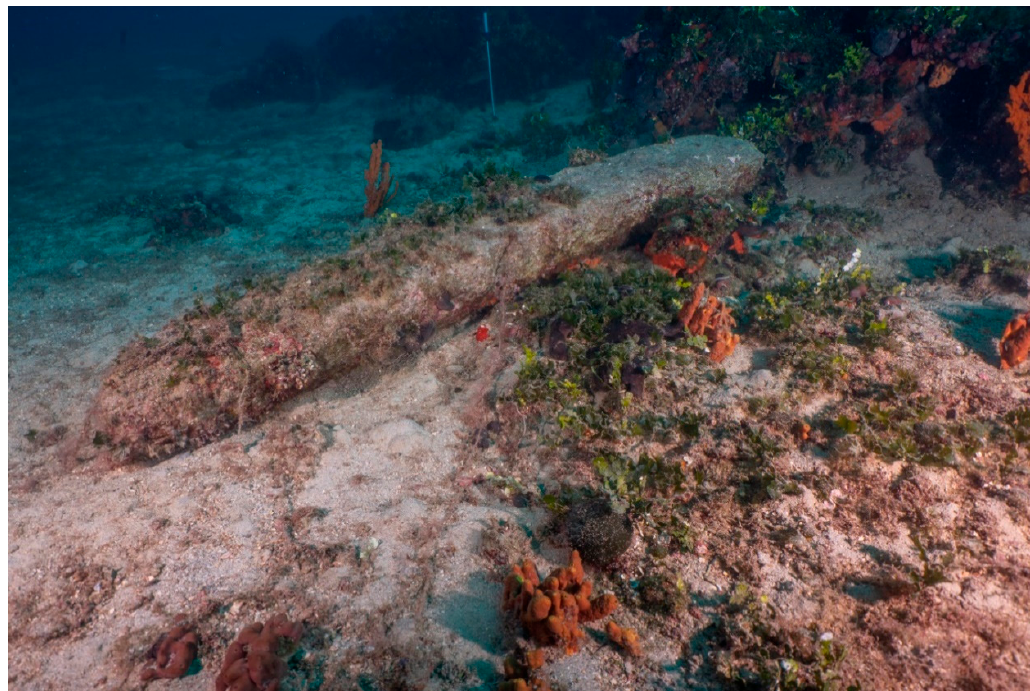
Figure 9. Archaic stone anchor belonging to the accessible underwater archaeological site of “Akra Glaros Cape” (Amaliapolis). ©MCS-EUA, photo by Matteo Collina, Università della Calabria–DIMEG.